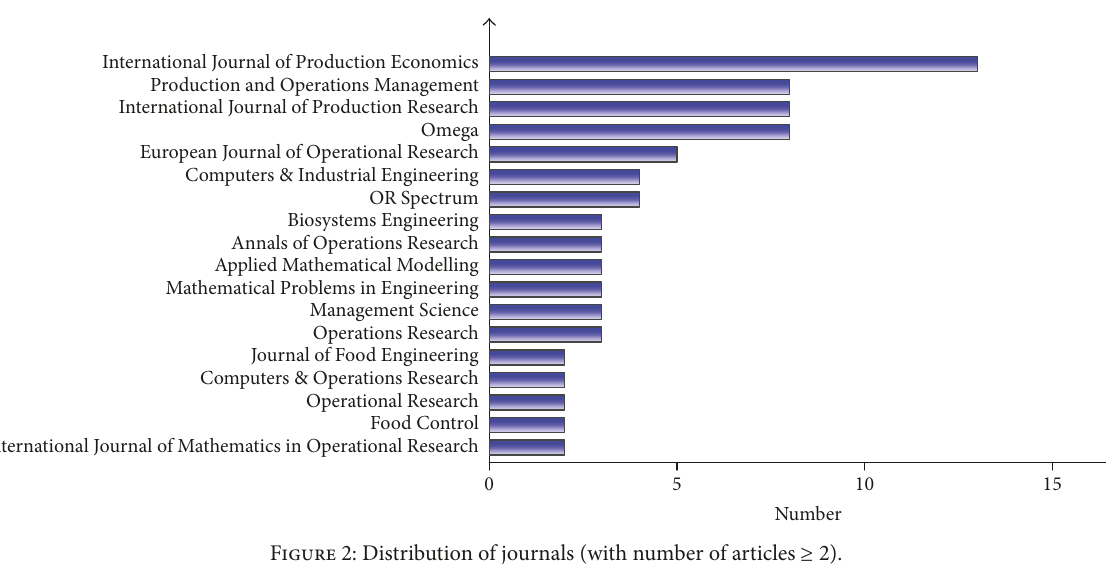
Figure 2: Distribution of journals (with number of articles ≥ 2).